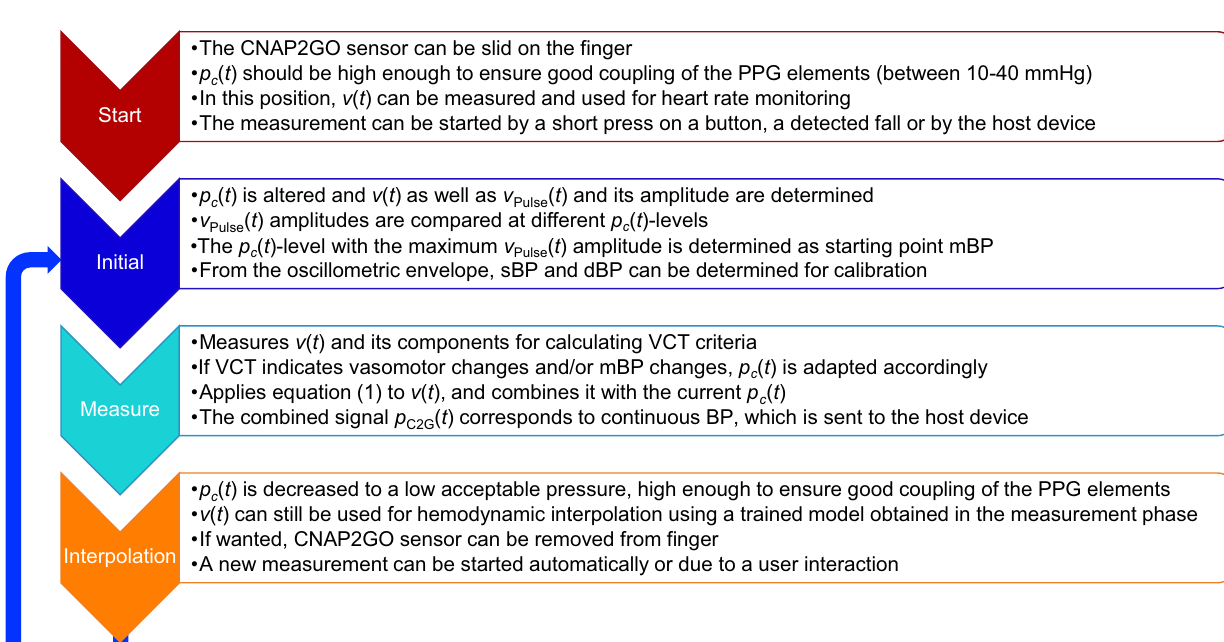
Fig. 12 Software fl ow chart of the different CNAP2GO modes. After the start mode, the system switches dynamically between initial, measure, and interpolation